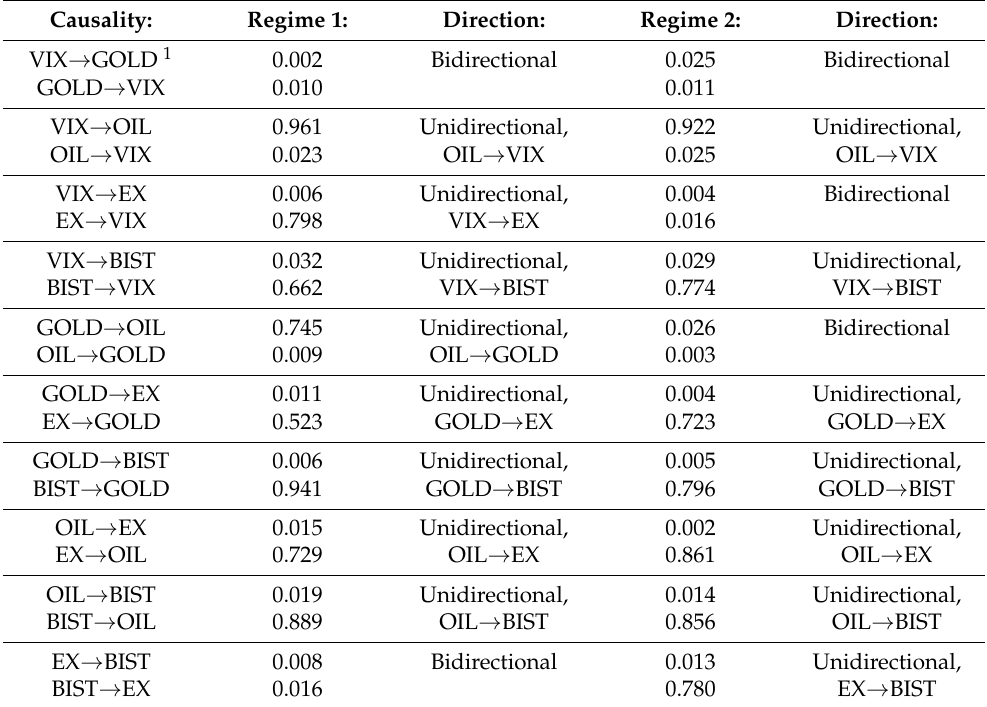
Table 6. MS-GARCH copula causality test